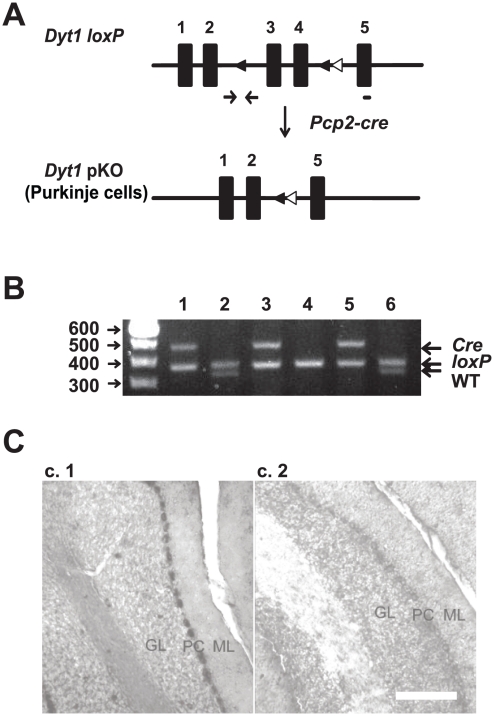
Generation of Dyt1 pKO mice.(A) Schematic diagram of the generation of the Dyt1 pKO mice. Filled boxes represent exons. Filled triangles indicate loxP sites. Open triangles indicate the FRT sites that were incorporated to remove the neo cassette. Dyt1 loxP mice were crossed with Pcp2-cre mice to obtain double heterozygotes. The double heterozygotes were crossed with Dyt1 loxP homozygotes to obtain Dyt1 pKO mice. The primer sites for genotyping of Dyt1 locus were shown by an arrow pairs. The short bar under exon 5 is the site of probe used for in situ hybridization. Dyt1 exons 3 and 4 were removed in Purkinje cells of Dyt1 pKO mice. (B) An agarose gel showing the various PCR products that were used to genotype mice. The top band indicates the presence of the Pcp2-cre locus, the middle band represents the Dyt1 loxP locus, and the bottom band represents the Dyt1 wild-type locus. Lanes 4: Dyt1 loxP homozygous mice. Lanes 2, 6: Dyt1 loxP heterozygous mice. Lanes 1, 3, 5: Dyt1 pKO mice. (C) In situ hybridization was used to confirm the Purkinje cell-specific knockout of the Dyt1 gene. CT (C.1) and Dyt1 pKO (C.2) mice. GL: granule cell layer; PC: Purkinje cell layer; ML: molecular layer. Scale bar represents 100 µm in C.2.